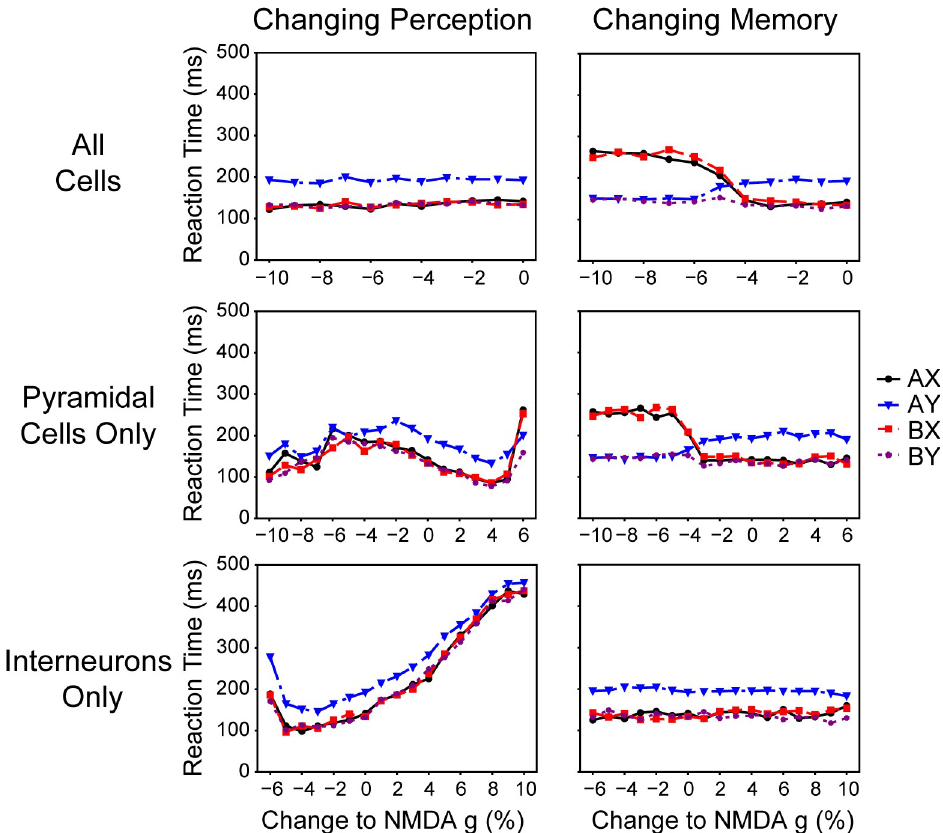
Fig 9. Specific network manipulation affected reaction times. The bifurcation of reaction times was specific to when the memory network was the direct cause of errors on AX and BX trials (top and middle left panels). Overall changes in reaction times were primarily caused by the perception network (middle and bottom left panels). This was due to the perception network becoming noisy (right and left of the middle and bottom left panels, respectively) or beginning to fixate (left and right of the middle and bottom left panels,